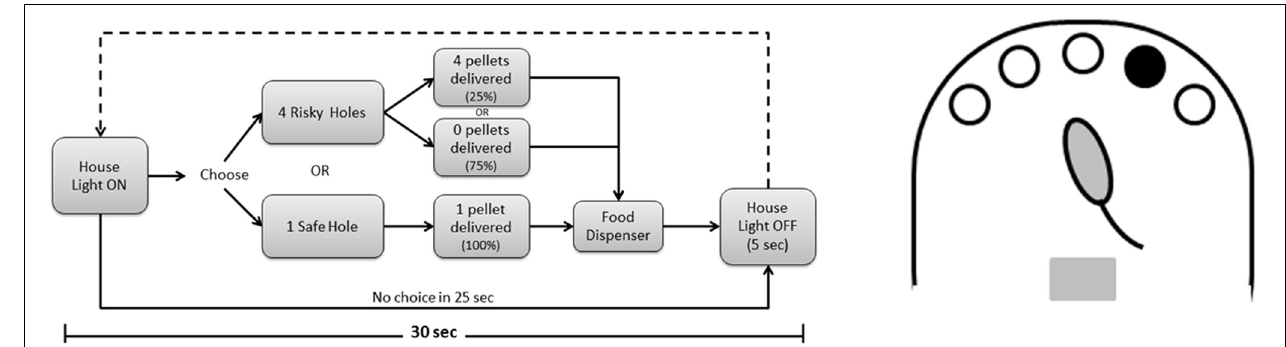
FIGURE 1 | Risk-taking task. Flow-chart of one trial in the neutral condition, in which the overall gain is the same for risky or safe choices; each daily session consisted of 100 trials or 30min of